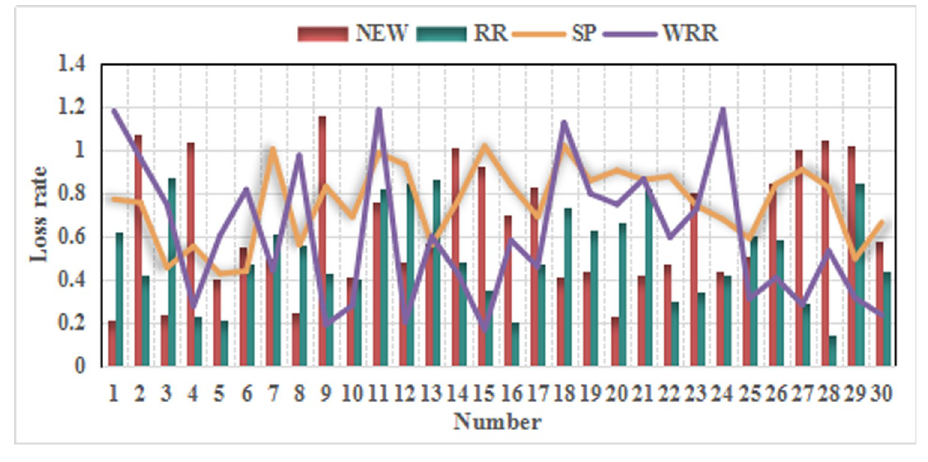
Fig 3. Unit operation.